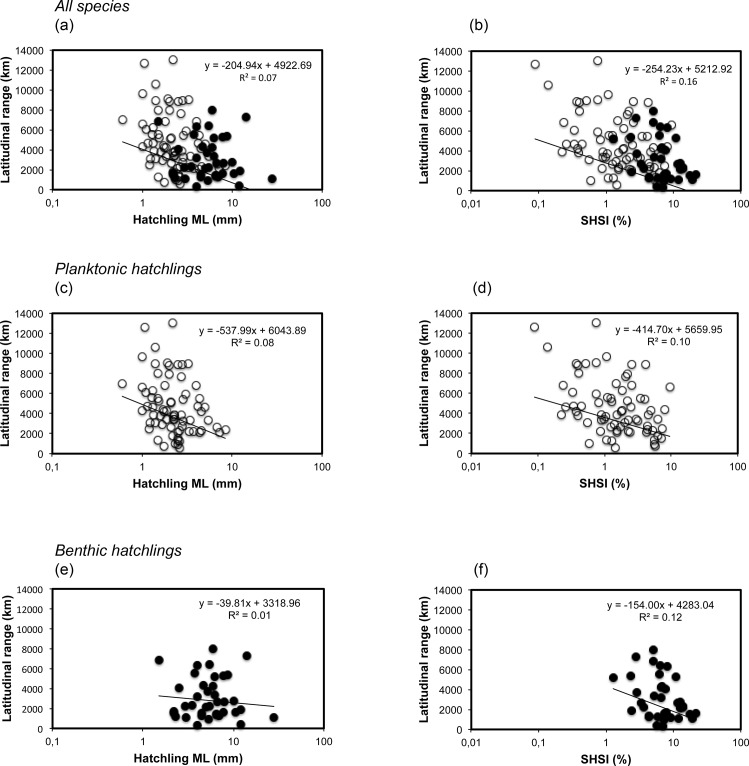
Relationship between hatchling size in mantle length (ML) and species hatchling size index (SHSI) with the latitudinal distribution range of cephalopod species hatched in the laboratory.a), c) and e) shows relationship between hatchling size and latitudinal distribution range of the species; b), d) and f), relationship between the SHSI and the latitudinal distribution range of the species. Data from a) and b) are based on all the 110 cephalopod species analysed in this study; data from c) and d) are based on 72 cephalopod species with planktonic hatchlings; data from e) and f) are based on 38 cephalopod species with benthic hatchlings. Logarithmic scale is used for the X-axis. Empty circles represent planktonic species; black circles benthic species.